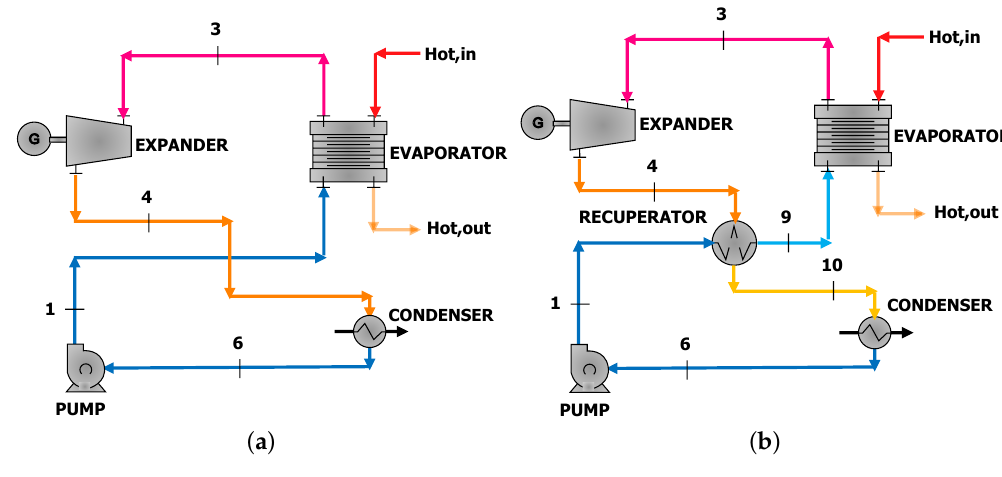
Figure 2. ( a ) ORC basic scheme and ( b ) recuperative ORC architecture. Table 3. Assumed machines and components efficiency for small-scale ORC units.